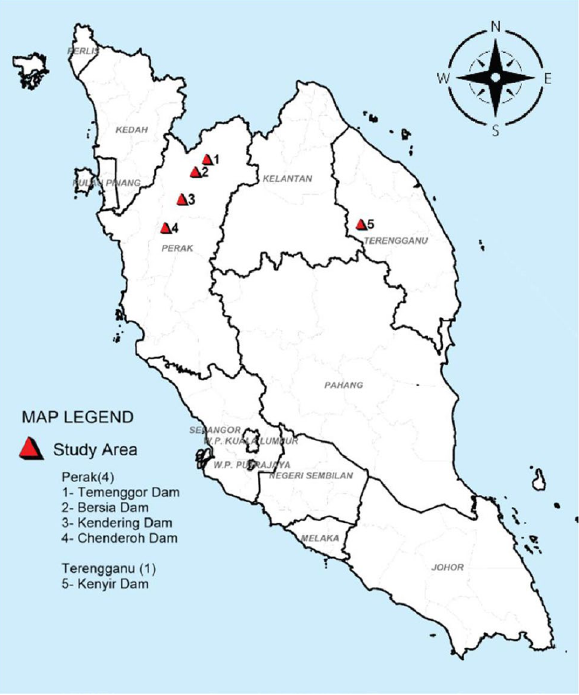
Fig. 2 The flowchart of the proposed hybrid BA-ANN model Fig. 3 Location of the five selected study areas in